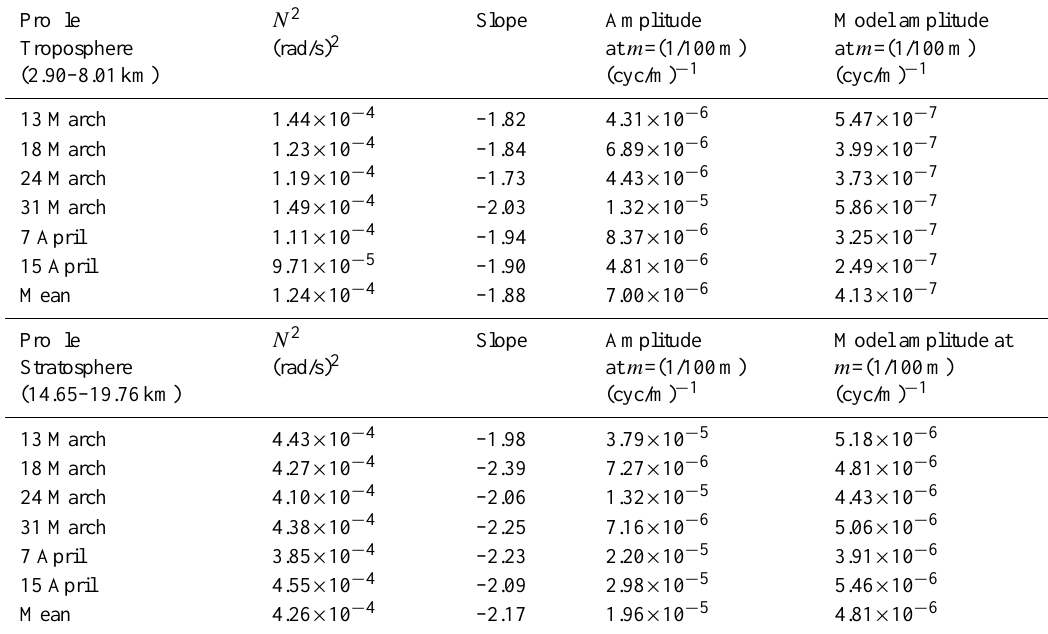
Table 1. Spectral slope and amplitude obtained from balloon soundings.